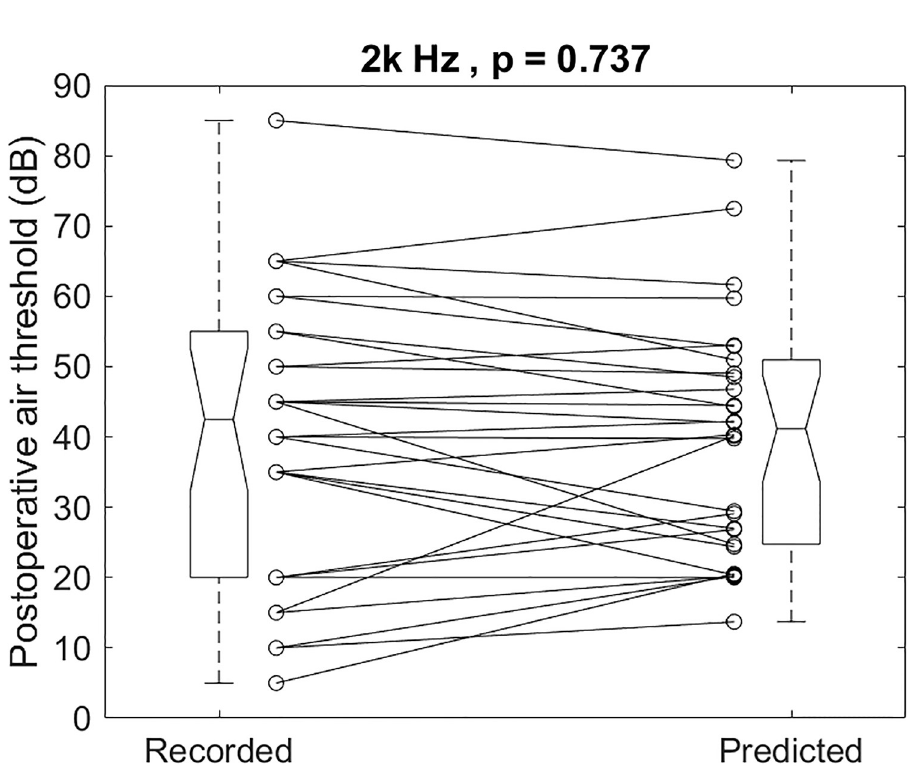
https://doi.org/10.1371/journal.pone.0248421.g009